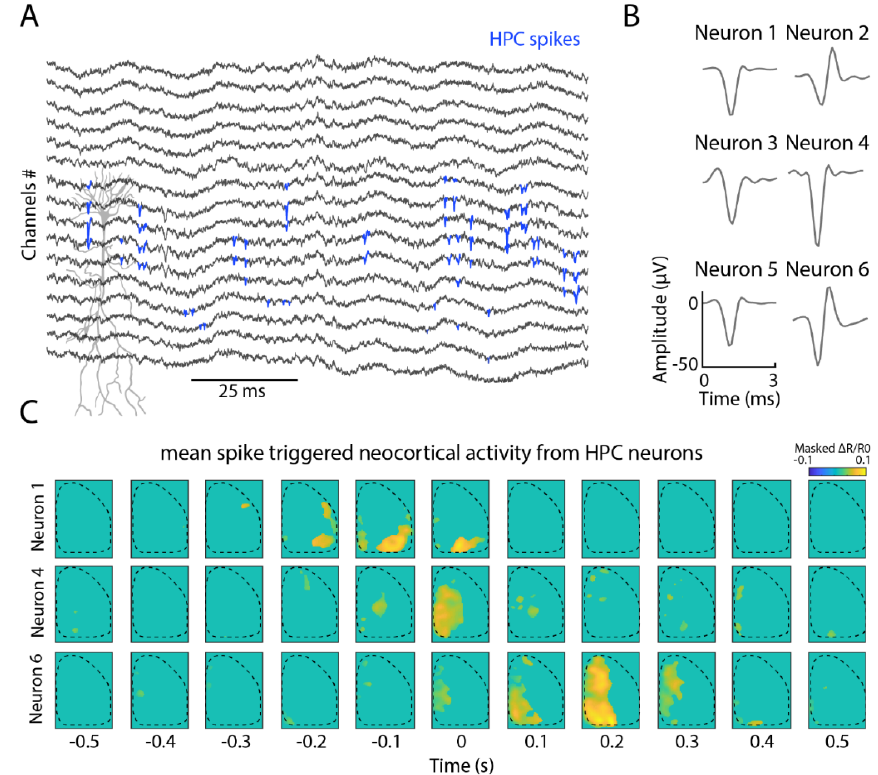
Figure 4. Combined cortical voltage imaging and hippocampal electrophysiological recordings re- veal different activity pattern types. ( A ) Local field potential from the silicon probe in the hippocampal CA1. In blue, putative spikes detected using kilosort 2.0. ( B ) Waveforms from 6 example neurons detected in the CA1 pyramidal layer. ( C ) Neocortical activation around spike activity from 3 neurons in the hippocampus. The plots are masked by the mean of the signal plus 5 standard deviations (N = 200 averaged shuffle spikes for each detected neuron).